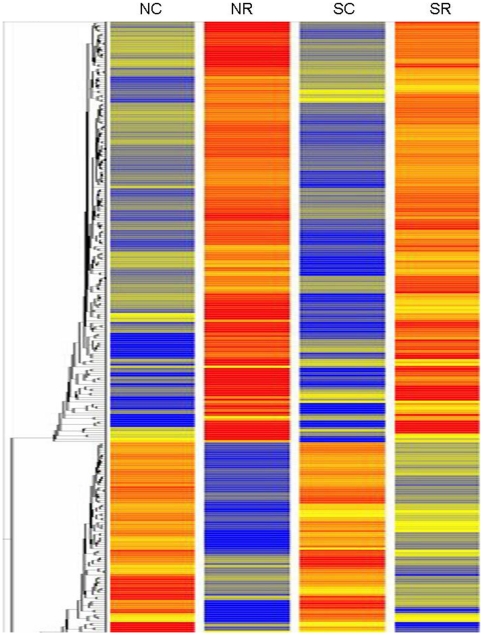
Heat map and dendrogram of differentially expressed transcripts.GeneSpring analysis of normal and SSc human dermal fibroblasts exposed to rottlerin. RNA was isolated from replicate samples of normal human dermal fibroblasts incubated under control conditions (NC) or cultured with 5 µM rottlerin (NR), or from SSc derived human dermal fibroblasts under control conditions (SC) or cultured with 5 µM rottlerin (SR), labeled and applied to Affymetrix human U133 2.0 Plus microarrays. Dendrograms are reflective of the genes with a differential expression of >2 fold in the two experimental conditions. In the dendrogram shown, a shorter arm indicates higher similarity, whereas a longer arm indicates lower similarity. Genes with significant expression (p<0.05) between untreated and rottlerin treated fibroblasts were hierarchically clustered by similarity in expression profile. The resulting heat map of the dendrogram tree reveals groups of genes with high (red) expression levels, low expression levels (blue) or background expression levels (yellow).